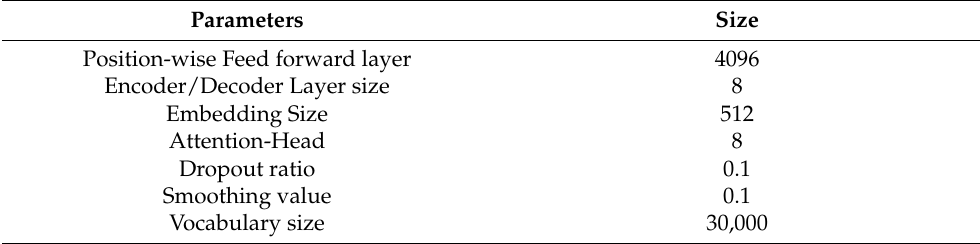
Table 8. Parameters